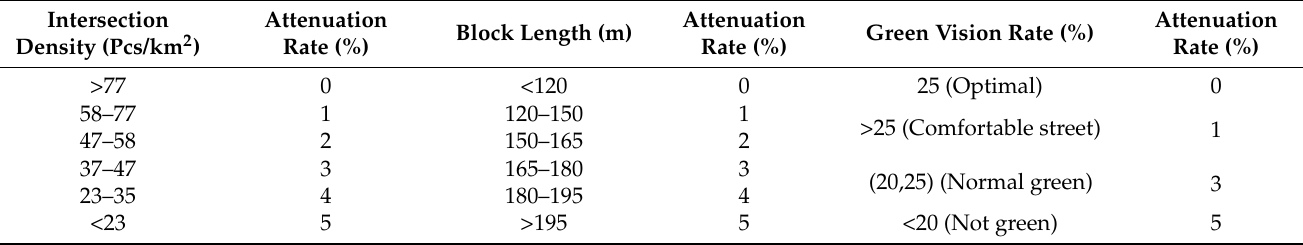
Table 4. Comparison table of intersection density, block length, and green view rate attenuation rate.